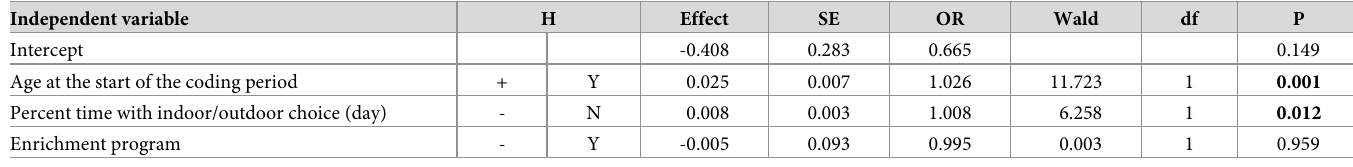
Table 13. Multivariate Poisson regression of factors associated with the number of skin lesions experienced by individual elephants that experienced at least one event (n = 77). Hypotheses (H): positive (+) or negative (-) relationship of each variable with the number of clinical events per animal as a measure of elephant welfare, and whether observed relationships were in the predicted direction (Y yes / N